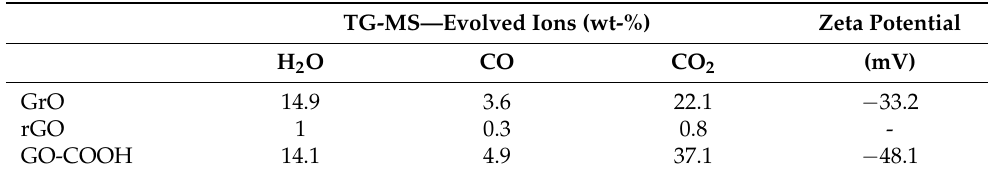
Table 3. Amounts (wt-%) of H 2 O, CO and CO 2 evolved in the TG-MS experiments, calculated by integration with a standard. The last column shows the zeta potential of 0.01 mg/mL aqueous suspensions with GrO, rGO and